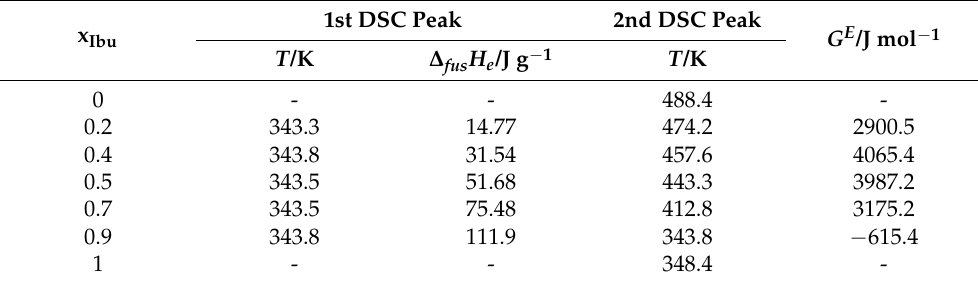
Table 2. Thermodynamic parameters for Drotaverine Hydrochloride and Ibuprofen system *.